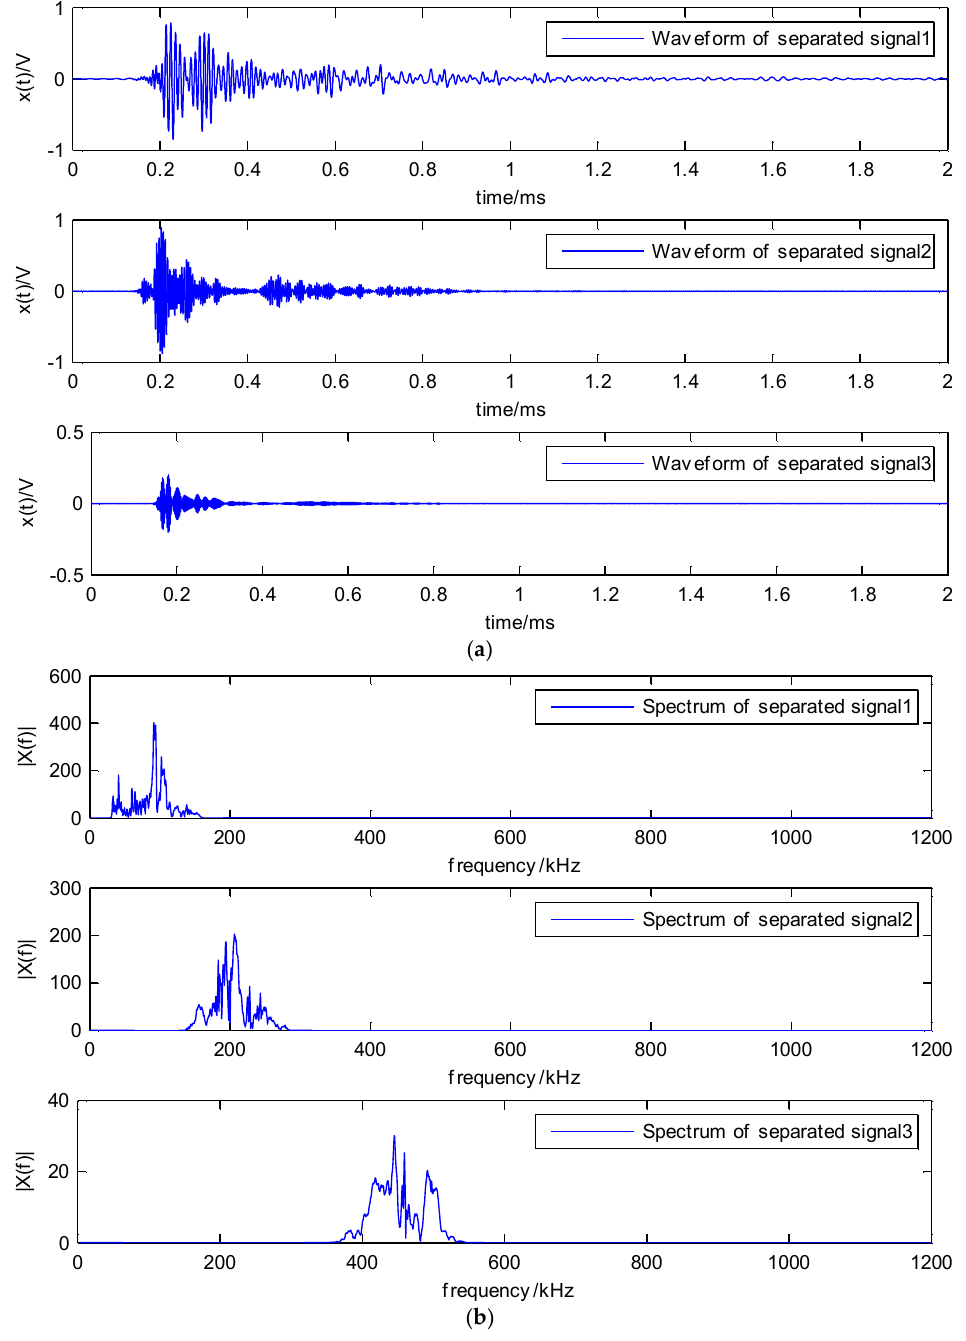
Figure 14. ( a ) The waveforms and ( b ) the spectrum of separated signals by the LWM-EWT method.